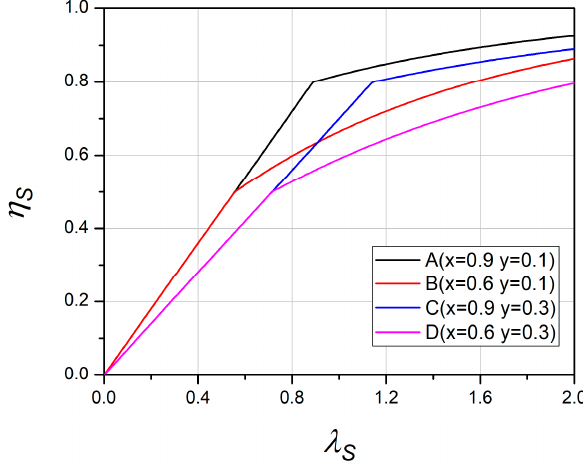
Figure 3. Scavenging efficiency-delivery ratio relationship of the Benson/Bradham model.